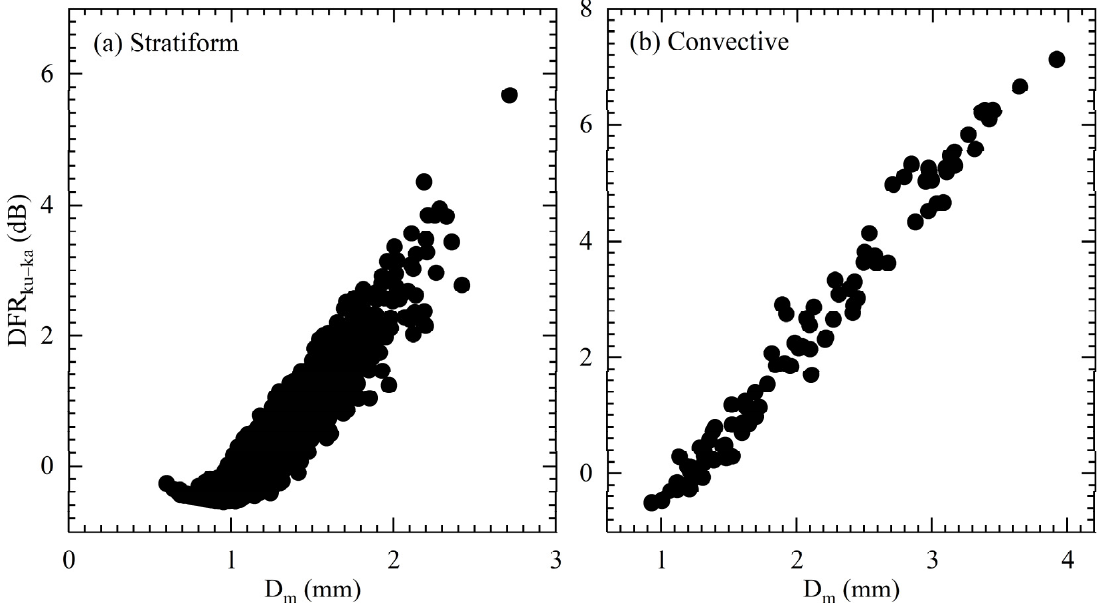
Figure 11. Scatterplots of the DFR vs. D m for ( a ) stratiform and ( b ) convective rainfall in Zhaosu.